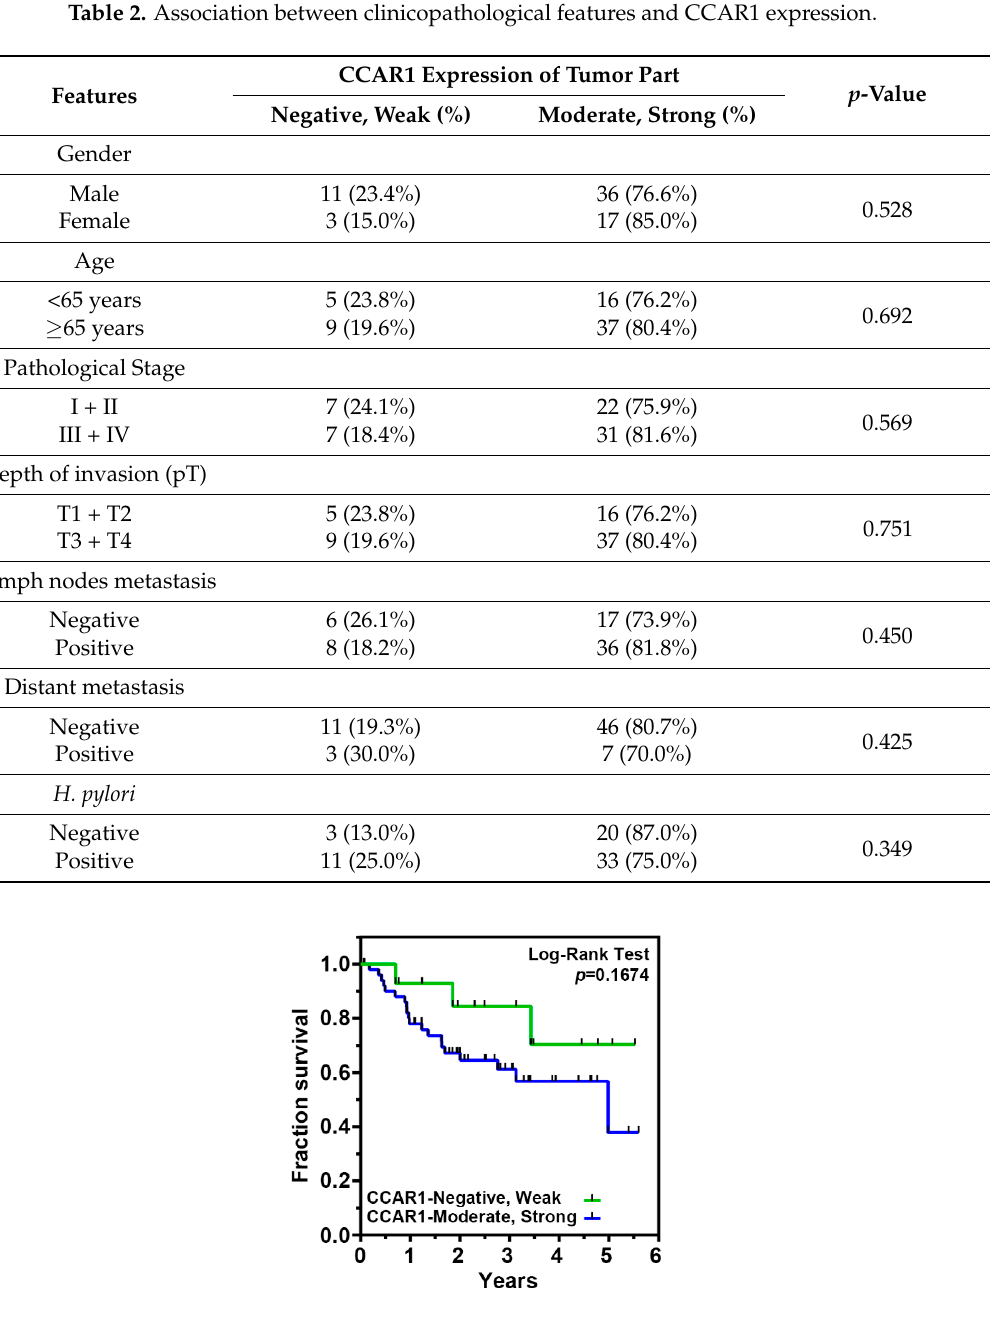
Figure 6. The relationship between CCAR1 expression and the outcome of patients with gastric cancer. Kaplan-Meier survival curves of patients with different CCAR1 expression.